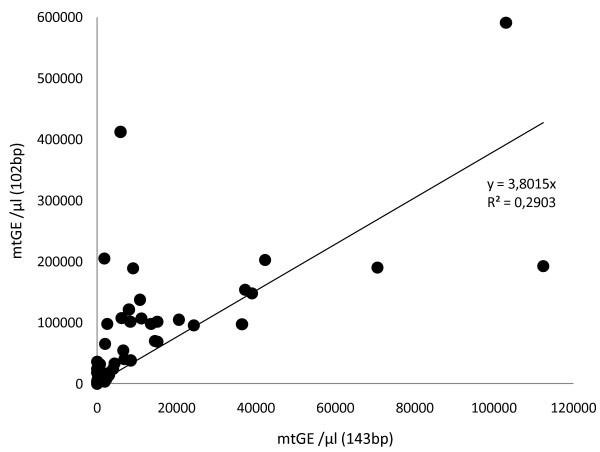
Regression between quantities of mitochondrial genomes (mtGE) measured with amplicons 102 bp and 143 bp in length. The intercept is forced to origin. R2 is the coefficient of determination of linear regression.